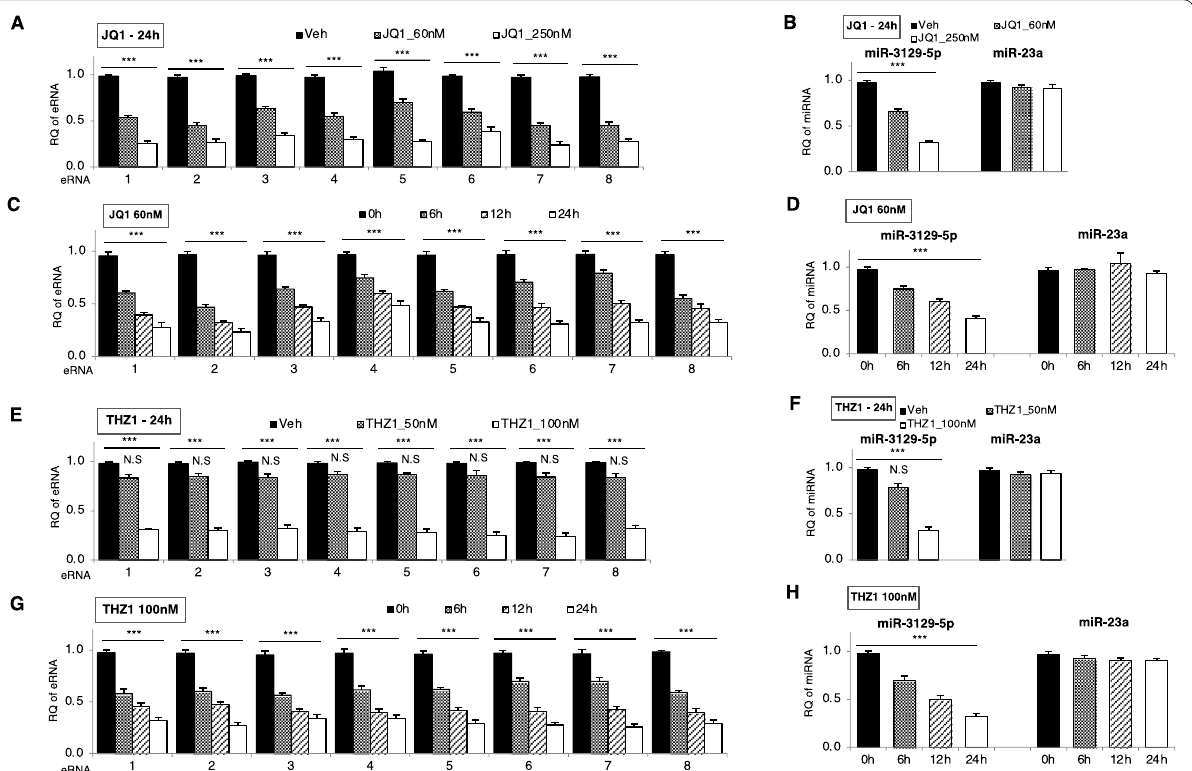
Fig. 2 miR‑3129‑5p expression was suppressed by SE inhibitors in a time‑dependent and dose‑dependent manner. A , C , E , G eRNA expression was examined at 24h after treatment of MSCs with the indicated concentrations of JQ1 ( A ) and THZ1 ( E ) and at the indicated time points after treatment of MSCs with 60 nM JQ1 ( C ) and 100 nM THZ1 ( G ). B , D , F , H Expression of miR‑3129‑5p and miR‑23a was examined at 24h after treatment of MSCs with the indicated concentrations of JQ1 ( B ) and THZ1 ( F ) and at the indicated time points after treatment of MSCs with 60 nM JQ1 ( D ) and 100 nM THZ1 ( H ). The levels of eRNA and miRNA expression were quantified by qPCR. The amounts of eRNA and miRNA transcripts were expressed relative to the amounts of GAPDH and U6sn transcripts, respectively. Data are expressed as mean SD from three independent experiments (each n 3 in ± = A – H ). *** p <0.001 vs. Veh or 0 h by one‑way ANOVA. N.S, not significant; RQ, relative quantification; Veh, vehicle